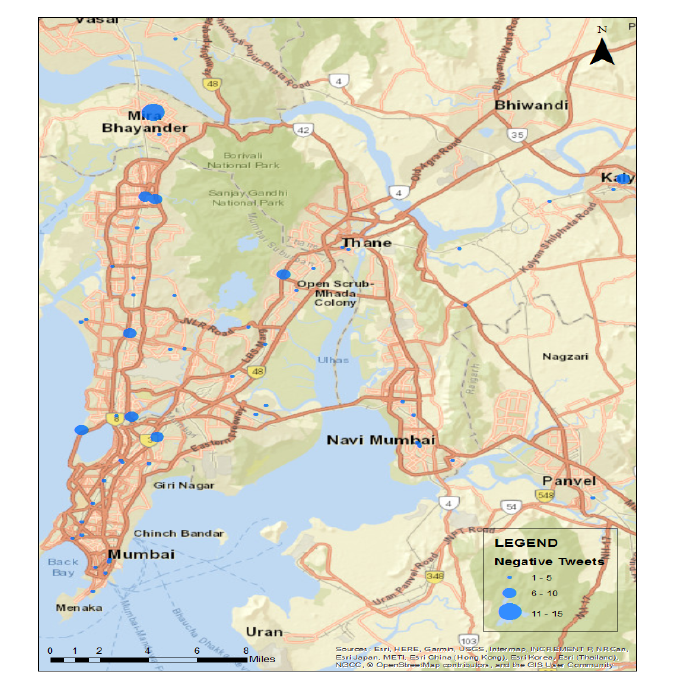
Figure 6. Map showing the distribution of negative tweets at different locations. The size of the blob is directly proportional to the number of negative tweets at a given